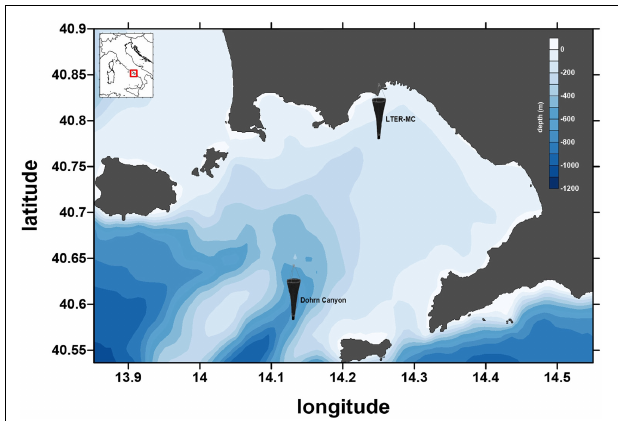
FIGURE 1 | The sampling site, the LTER-MC site and Canyon Dohrn (plankton net icons), in the Gulf of Naples (Central Tyrrhenian Sea, Mediterranean Sea). Coastline data: NOAA National Geophysical Data Center, Coastline extracted: WLC (World Coast Line), Date Retrieved: April 01, 2015, http://www.ngdc.noaa.gov/mgg/shorelines/shorelines.html; bathymetric data from Amante and Eakins (2009).